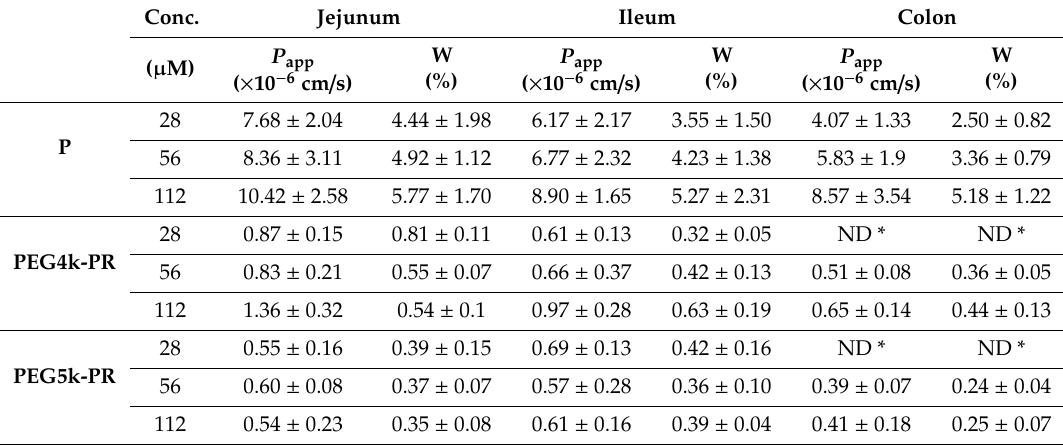
Table 3. Apparent permeability coe ffi cients ( P app ) (cm / s) and cumulative permeable percentage of PR, PEG4k-PR, and